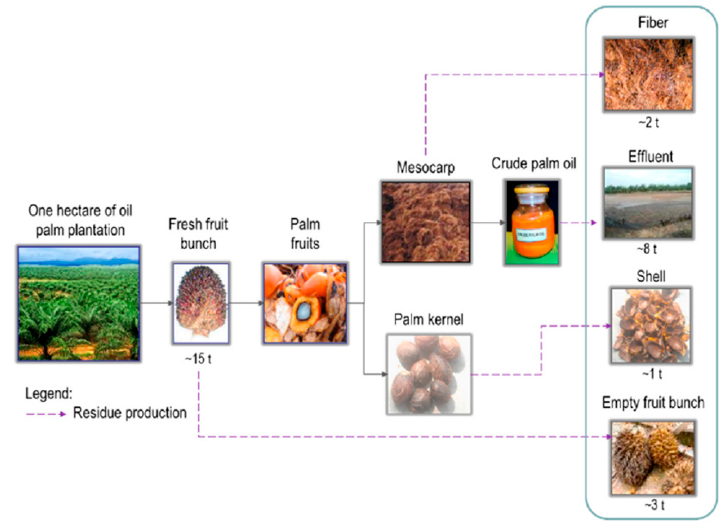
Figure 1. Flow of crude palm oil production [1].